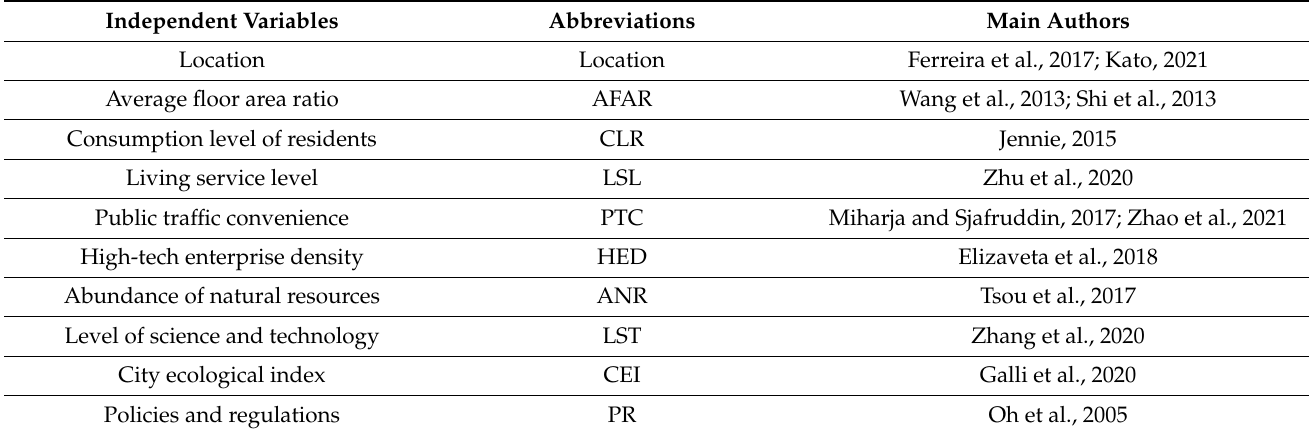
Table 1. Summarization of the factors influencing the urban carrying capacity.